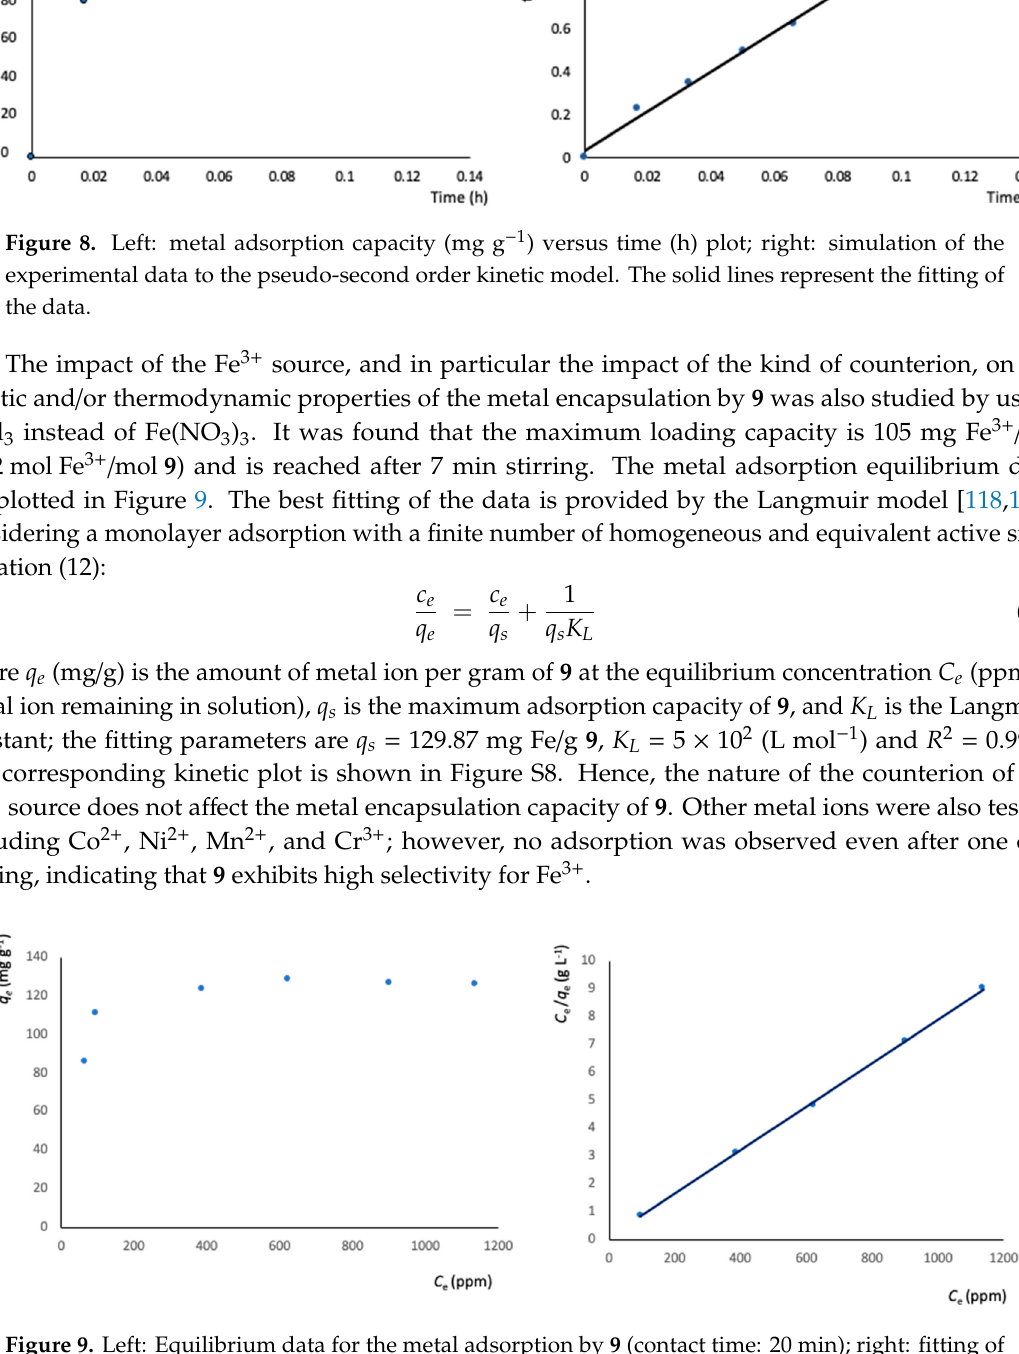
Figure 9. Left: Equilibrium data for the metal adsorption by 9 (contact time: 20 min); right: fitting of the metal adsorption data to the Langmuir model.